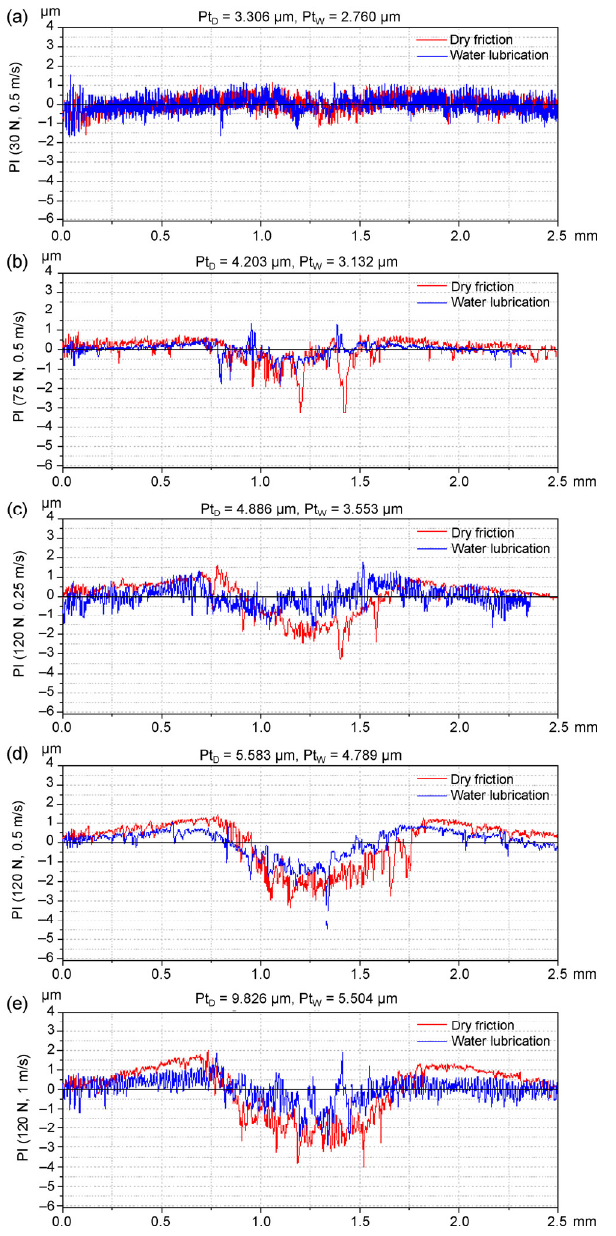
Fig. 12 Cross-sectional profiles of wear tracks from 2-D PI surface topography.